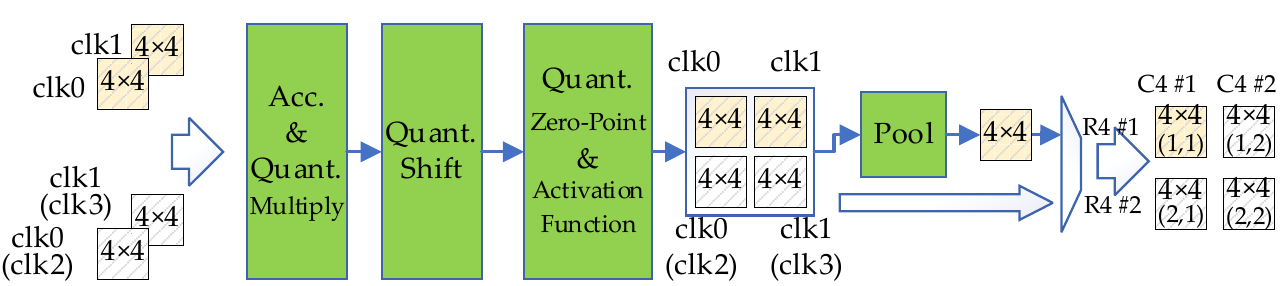
Figure 9. The details of OFM generator.